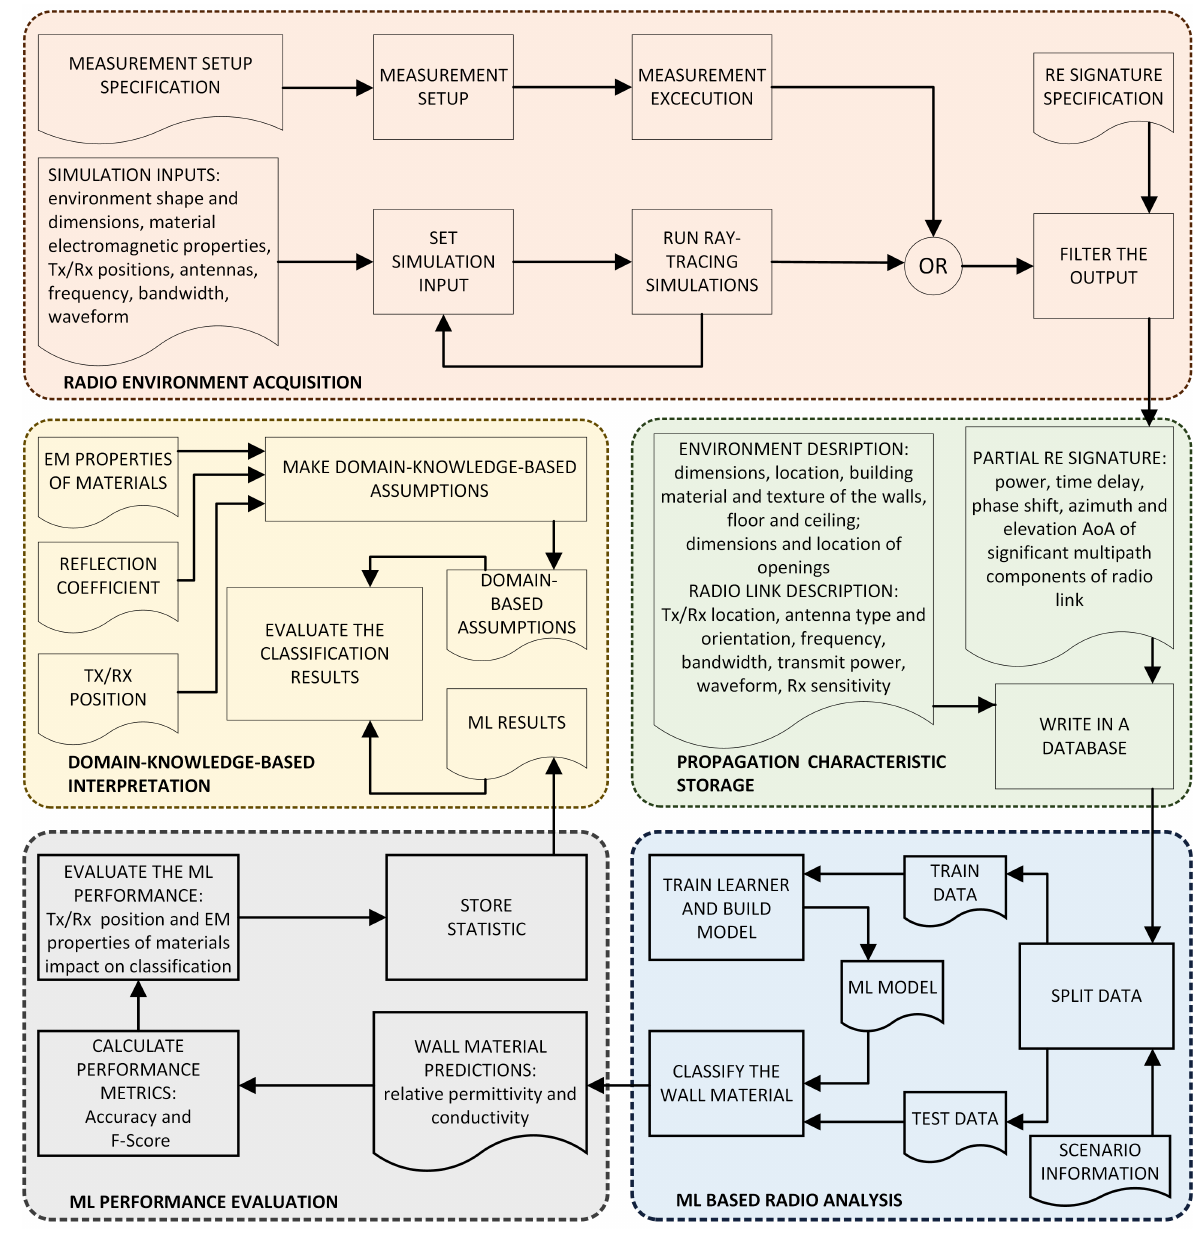
Figure 2. Wireless sensing framework